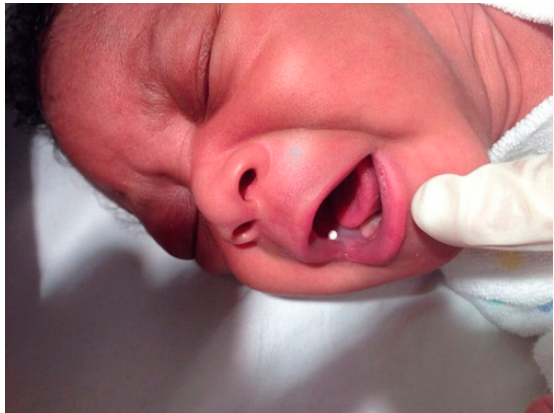
Figure 2. Newborn child with uncoated mini-tablet in the cheek pouch before swallowing (with permission to use from Thabet et al. 2018 [132]).